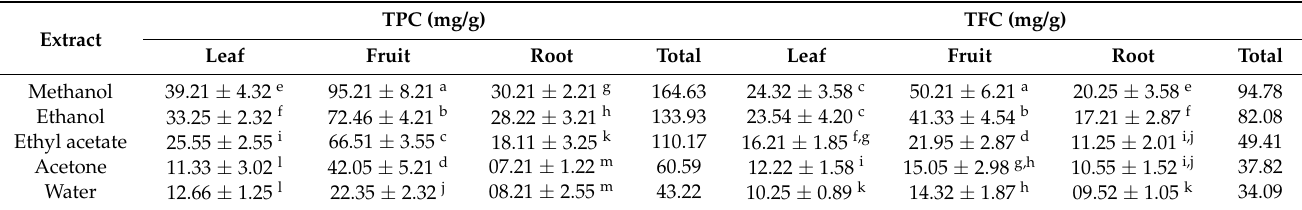
Table 1. Total phenolic content (TPC) and total flavonoid content (TFC) of white Panax ginseng in five different solvents.